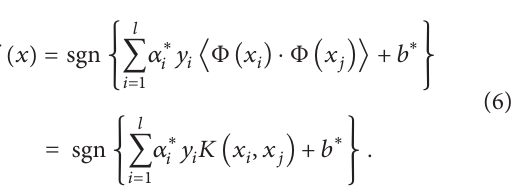
Table 1: The statistic features in time domain.